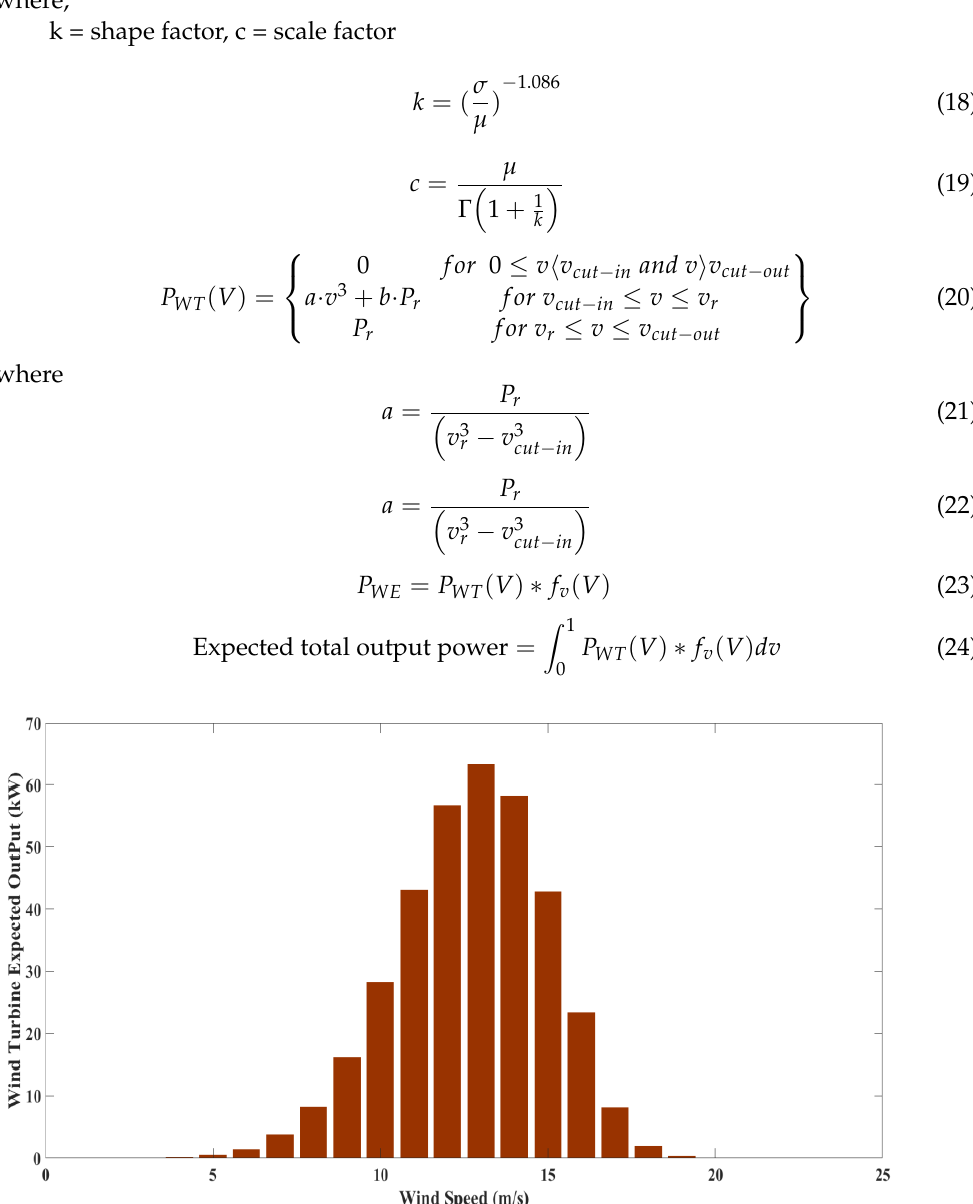
Figure 3. Wind turbine expected output power for 1 h.